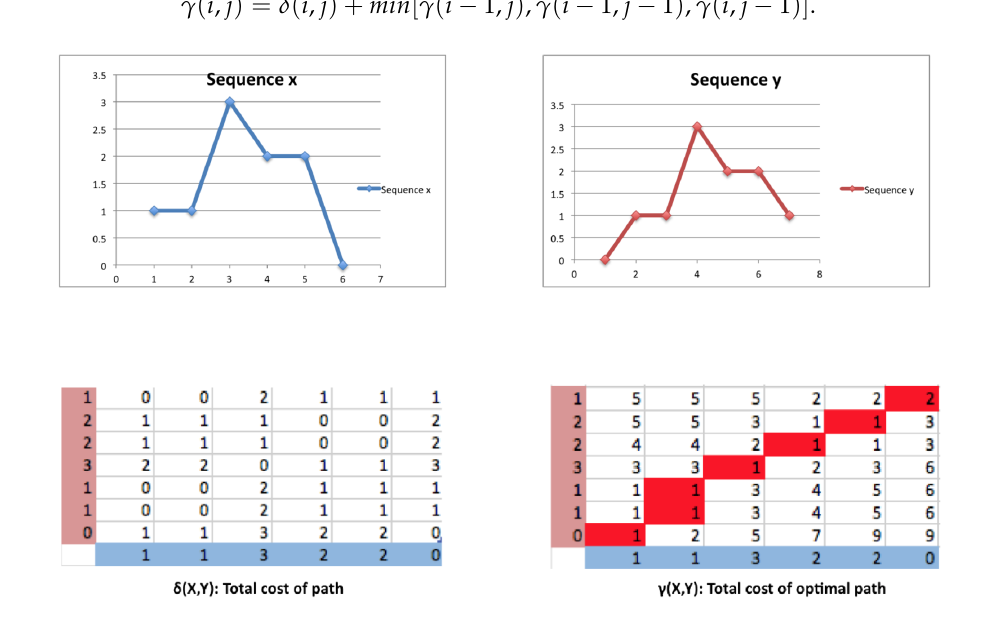
Figure 2. Example of the similarity comparison of two sequences using DTW. The δ distance measures the distance between two points in the time series. γ is the cumulative distance for each point. The closer to the diagonal the warping path is located, the more similar the two sequences